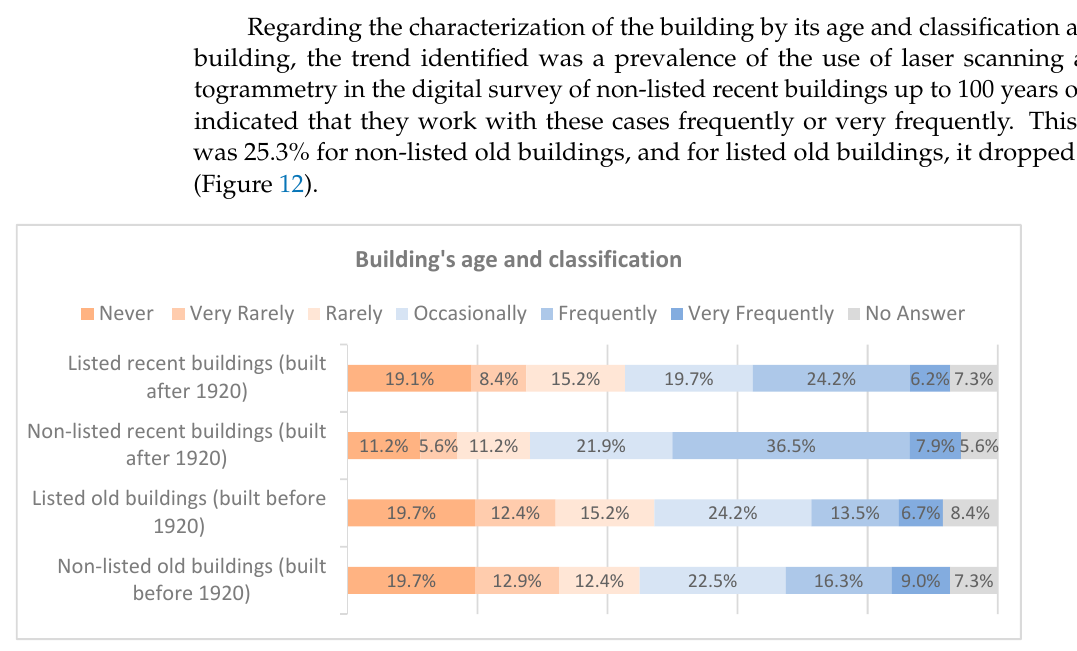
Figure 12. Trend chart of the frequency of work on scan-to-BIM projects according to the building’s age and classification. The use of point clouds generated from surveys with 3D laser scanning was predom- inant in 92.7% of the cases, and 46.0% of the participants indicated using it exclusively. On the other hand, 46.7% of professionals use them combined with point clouds generated by digital photogrammetry. Finally, only 5.5% use photogrammetry as the only tool to capture reality.